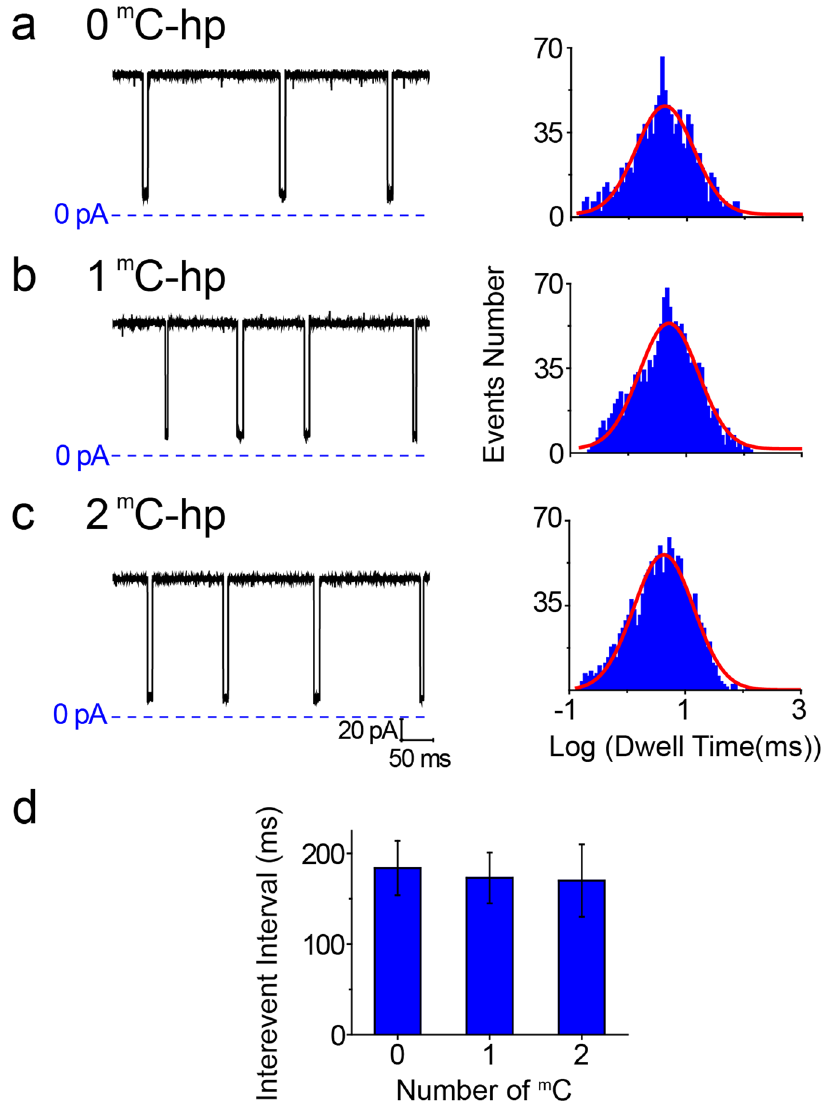
Figure 2. Protein nanopore sensing for DNA methylation in KCl. ( a – c ) The representative current traces (the left panel) of 0 m C-hp ( a ), 1 m C-hp ( b ) and 2 m C-hp ( c ) in 1 M KCl. The corresponding histograms of the dwell time in log form are shown in the right panel. ( d ) Mean interevent interval, (n = 4) obtained from different methylated DNA in 1 M KCl. Other experimental conditions are the same as Fig.